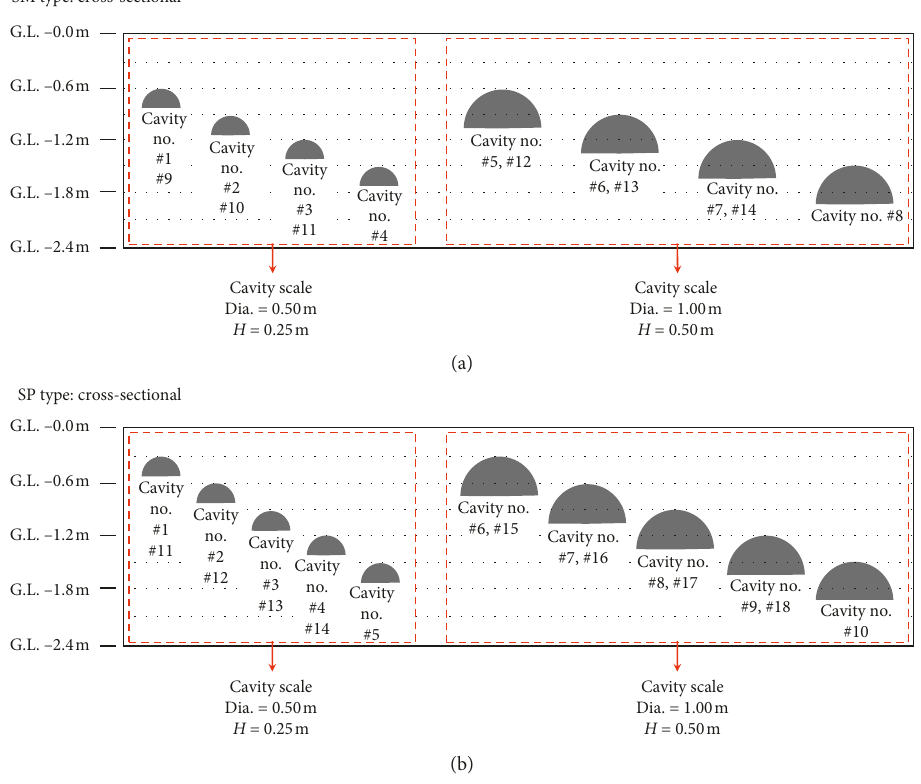
Figure 11: Experiment types. (a) Detailed map of SM type. (b) Detailed map of SP